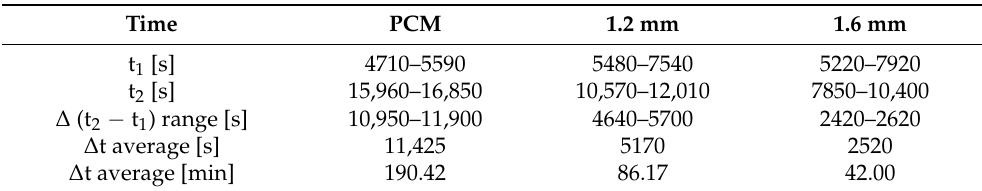
Table 3. Starting time of the deposit’s melting at the height of the bottom (h = 12 mm) thermocouple (t 1 ) and the top (h = 87 mm) thermocouple (t 2 ) and the calculated duration of the deposit’s melting (delta) for the tested cases: a pure mixture of salts, PCM, and an insert with a wall thickness of 1.2 mm, and a PCM insert with a wall thickness of 1.6 mm. Time